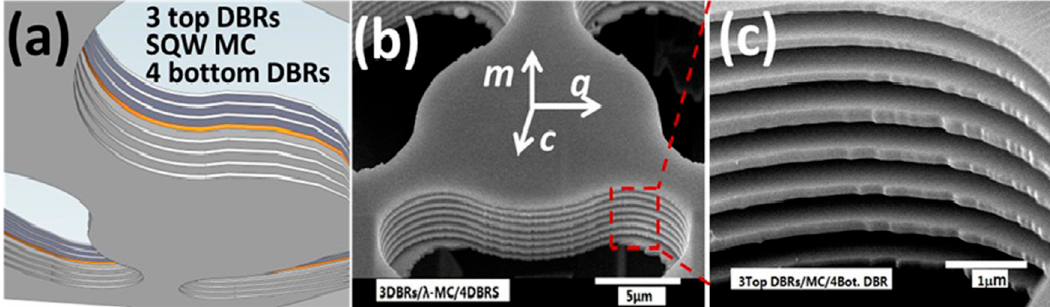
Figure 11. ( a ) Schematic image (view from inside); ( b ) SEM image of the fabricated nitride air-gap micro cavity (MC) (3 top DBRs / MC / 4 bottom DBRs); ( c ) close SEM view of the edge DBR micro cavity (MC) (3 top DBRs/MC/4 bottom DBRs); ( c ) close SEM view of the edge [104]. Copyright 2013 Appl. Phys. Lett.